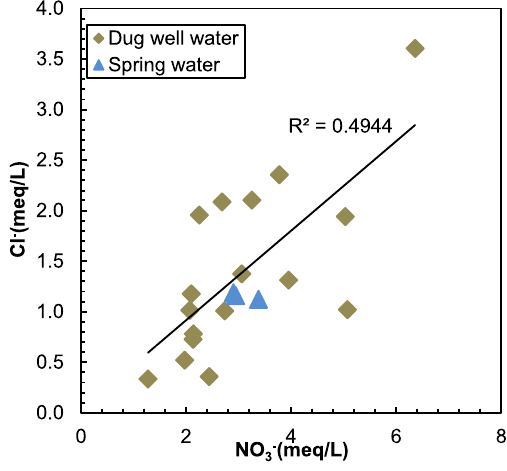
Fig. 8 Cl − versus NO 3− of the water samples in the study